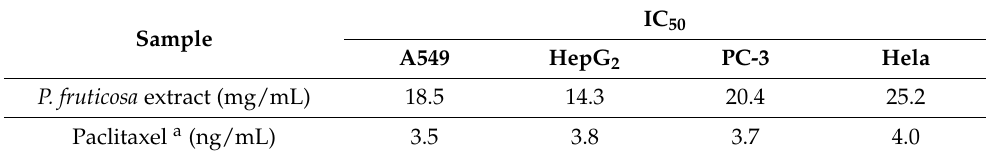
Table 6. The cytotoxic activity of P. fruticosa root extract against several cancer cell